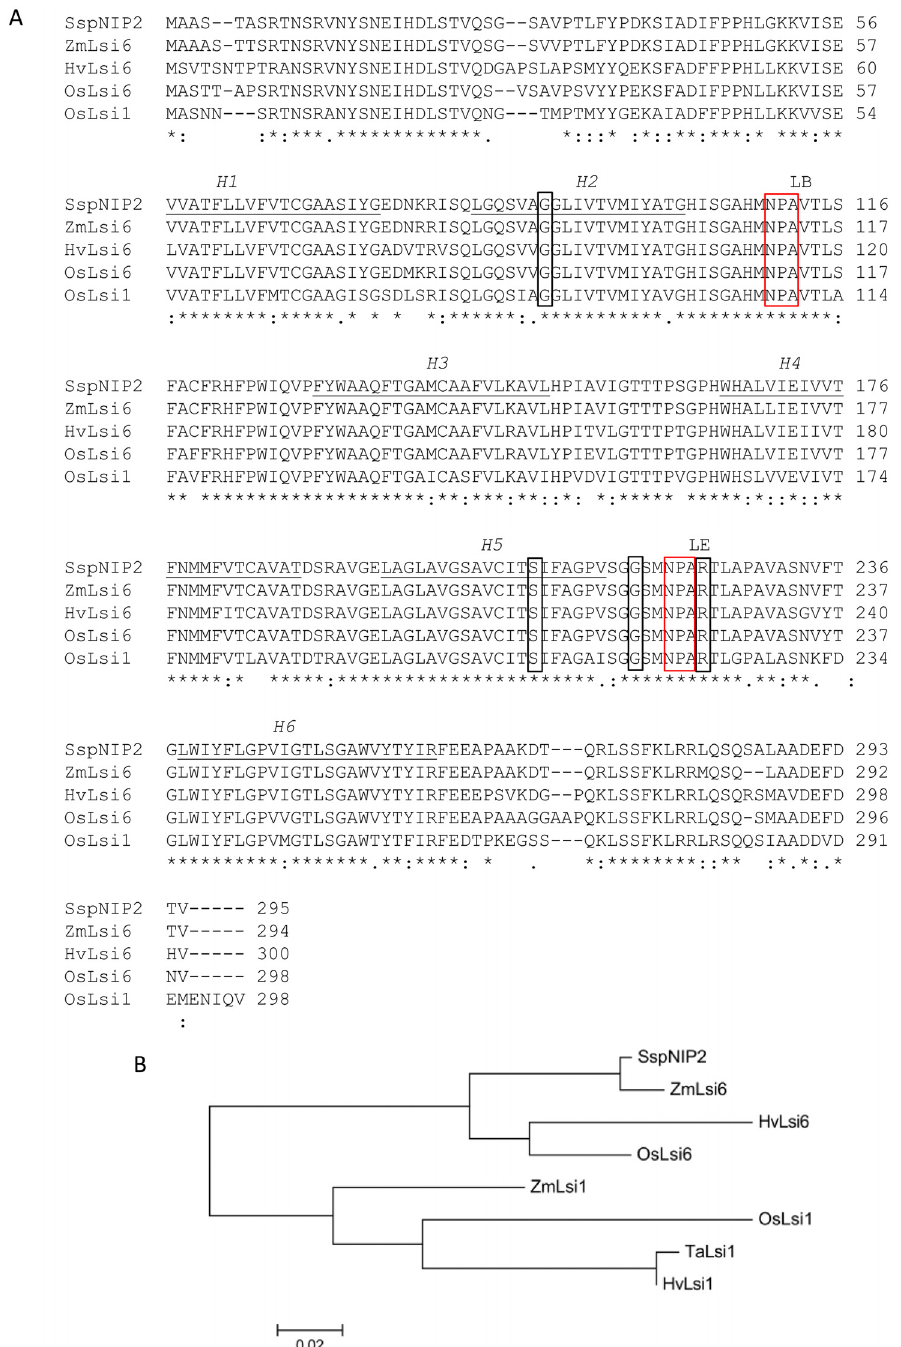
Fig 3. SspNIP2 amino acid sequence analysis. A. Amino acid sequence alignment of SspNIP2 with monocot silicon transporters; Maize ZmLsi6 (NM001111550), Barley HvLsi6 (AB447484.1), Rice OsLsi6 (AB253627.1) and OsLsi1 (AB222272.1). Six transmembrane domains, H1 to H6, were predicted by Membrane Protein Explorer version 3.2.11. Two NPA motifs and four amino acid residues constituting ar/R selectivity filter of SspNIP2 and monocot silicon transporters are indicated in red and black open boxes, respectively. B. Phylogenic analysis of SspNIP2 with monocot silicon transporters; Maize ZmLsi6 (NM001111550) and ZmLsi1 (DQ524811.1), Barley HvLsi6 (AB447484.1) and HvLsi1 (AB447482.1), Rice OsLsi6 (AB253627.1) and OsLsi1 (AB222272.1), and Wheat TaLsi1 (HM803114.1). Phylogenetic tree was generated by Maximum Likelihood method using MEGA6 [23].